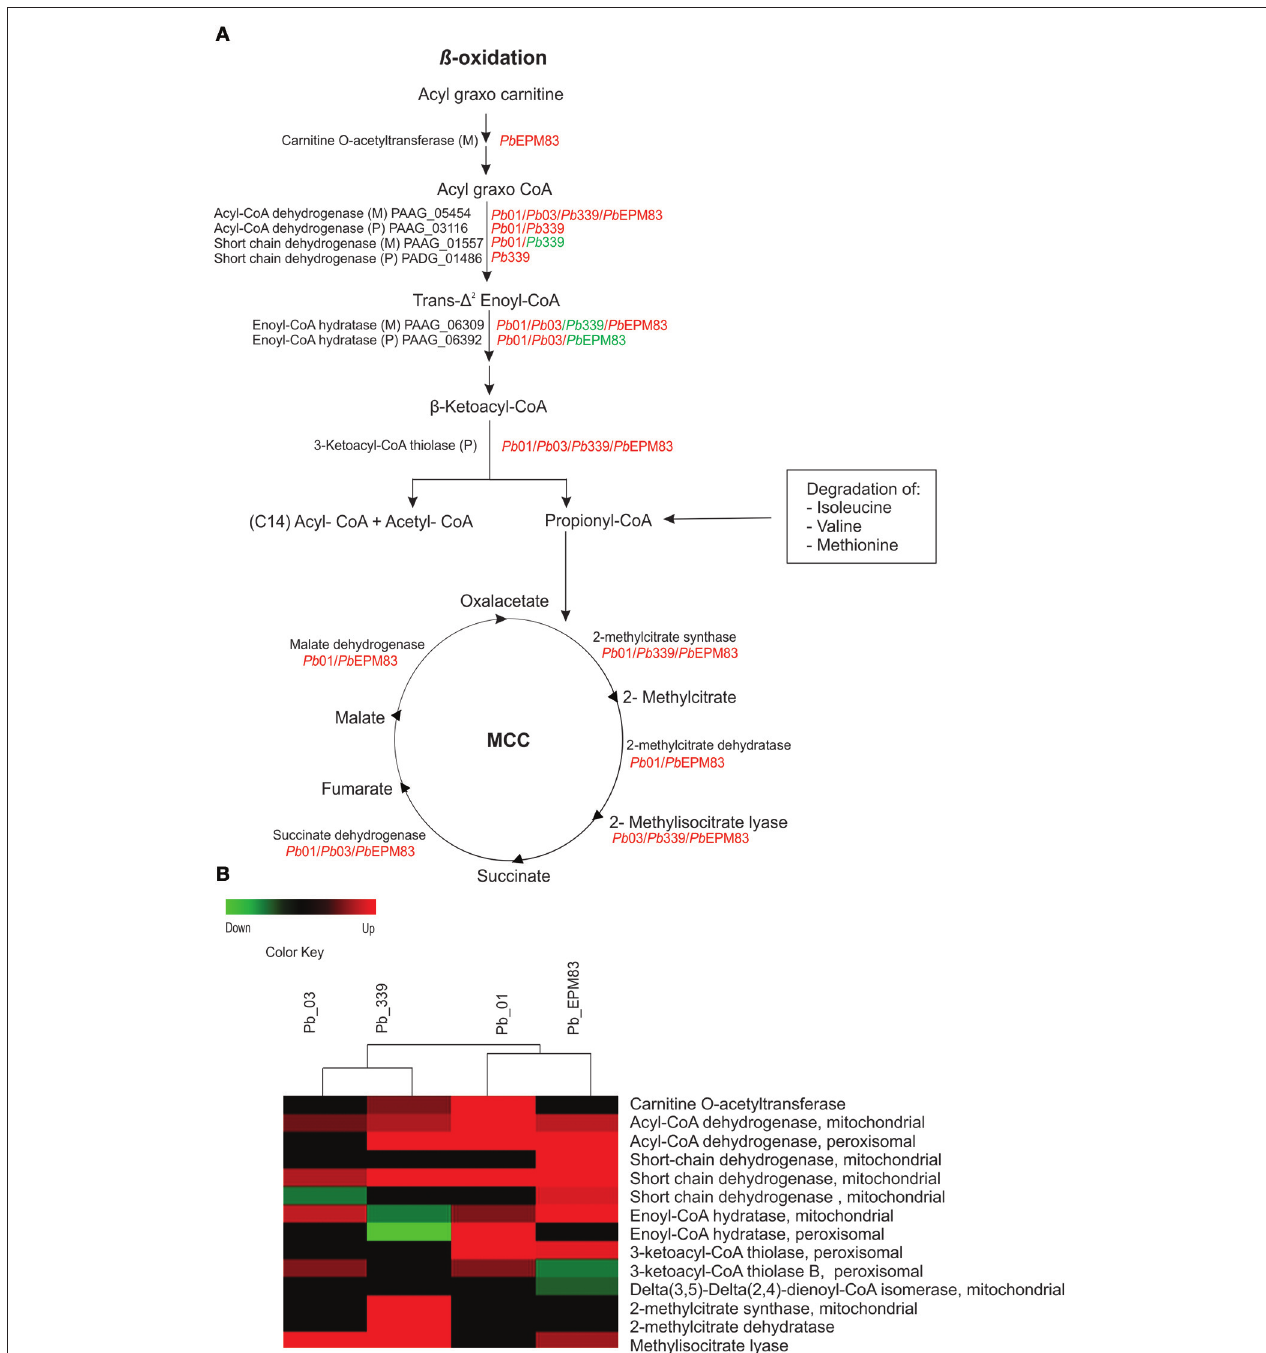
FIGURE 6 | Comparison of protein profiles related to β -oxidation and methyl citrate cycle in P. lutzii and isolates of P. brasiliensis . Dataset comparisons were carried out as cited in Figure 2, legend. (A) Representative diagram of the β -oxidation and methyl citrate cycle pathways depicting down-regulated (green) and up-regulated (red) proteins in the isolates (B) Changes in expression levels in yeast cells incubated with acetate in Pb 01, Pb 03, Pb 339, and Pb EPM83 are represented in a heat map format. Black indicates that no significant difference was observed. glycine was observed in Pb 01, Pb 03, and Pb EPM83 with the induction of the enzyme glycine dehydrogenase (PAAG_1568; PABG_04990) ( Figure 7 and Supplementary Figure 5). Pb